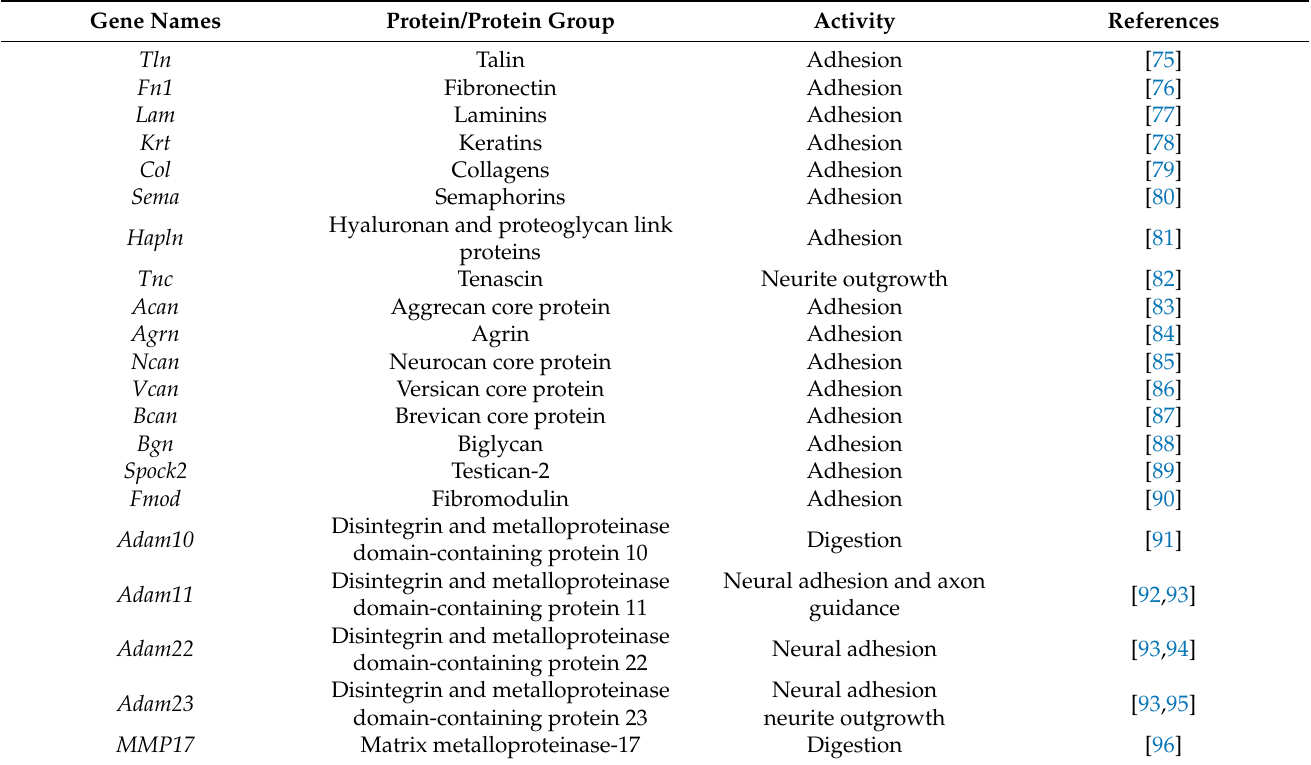
Table 2. ECM, or extracellular matrix, proteins involved in cell adhesion and, thus, regulation of neuronal development, axon guidance, synapse formation (maturation) and neuronal